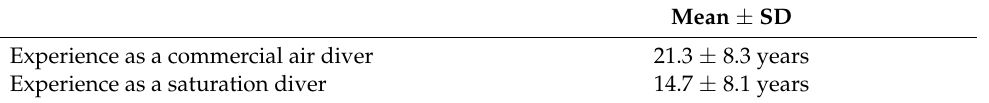
Table 2. Participants diving experience (commercial experience includes Saturation